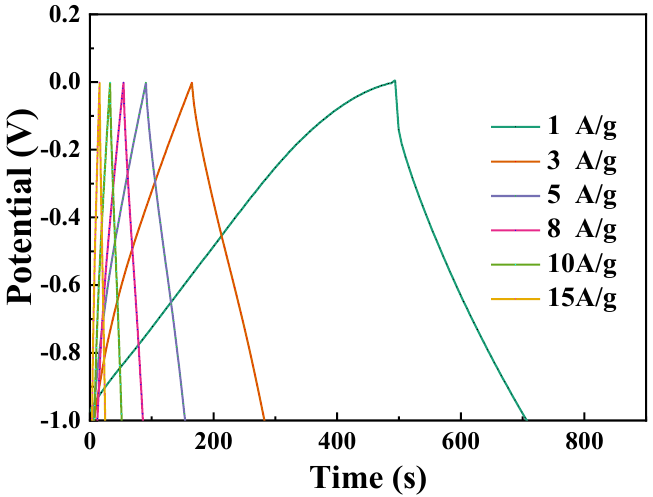
Figure 6. Charge-discharge test curves of the CNTs electrode for varied current densities.